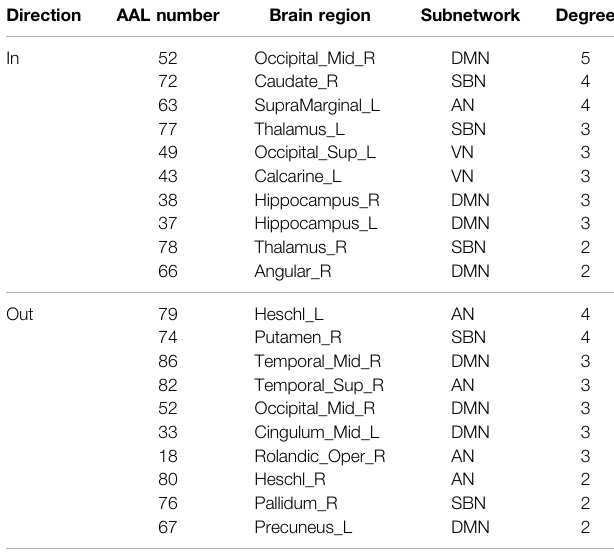
TABLE 8 | Top-10 brain regions corresponding to consensus connections based on the GCM method. Direction Brain